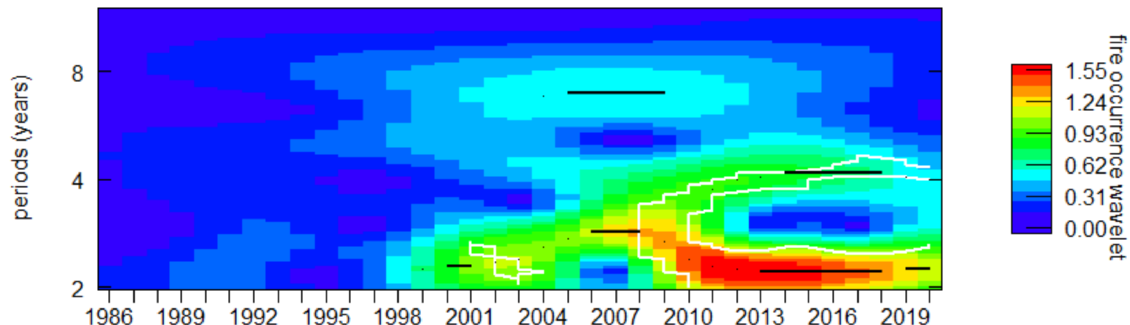
Figure 12. Wavelet transform of lightning-fire occurrence.